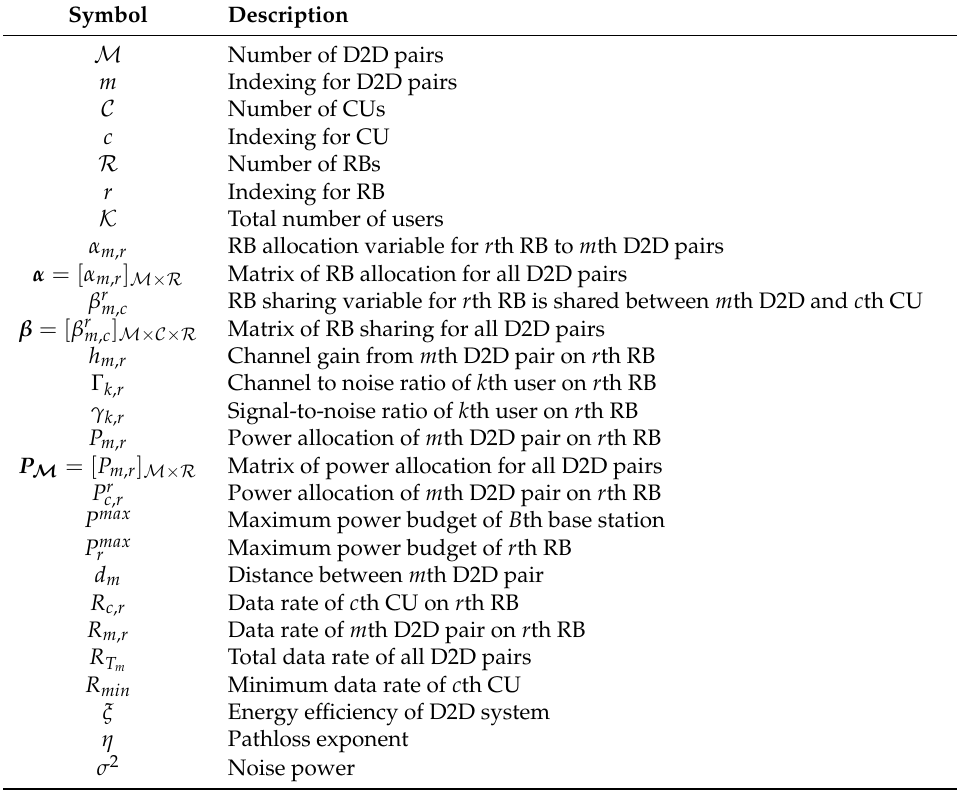
Table 2. List of